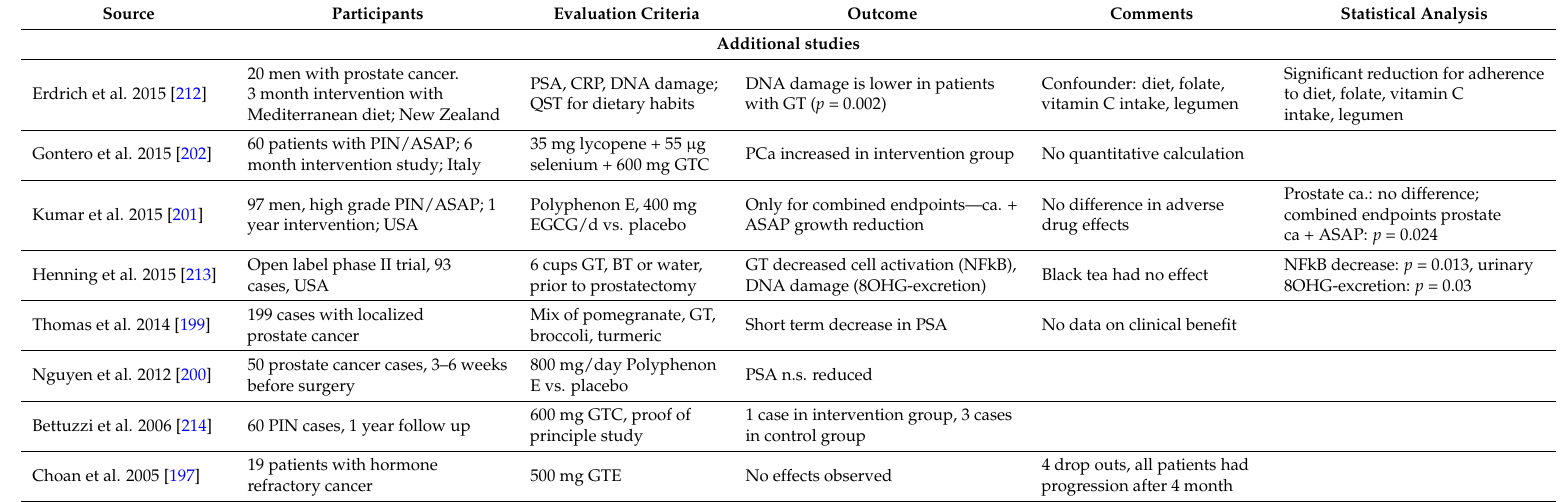
Table 7. Green tea effects, surrogate parameters and intervention studies for prostate